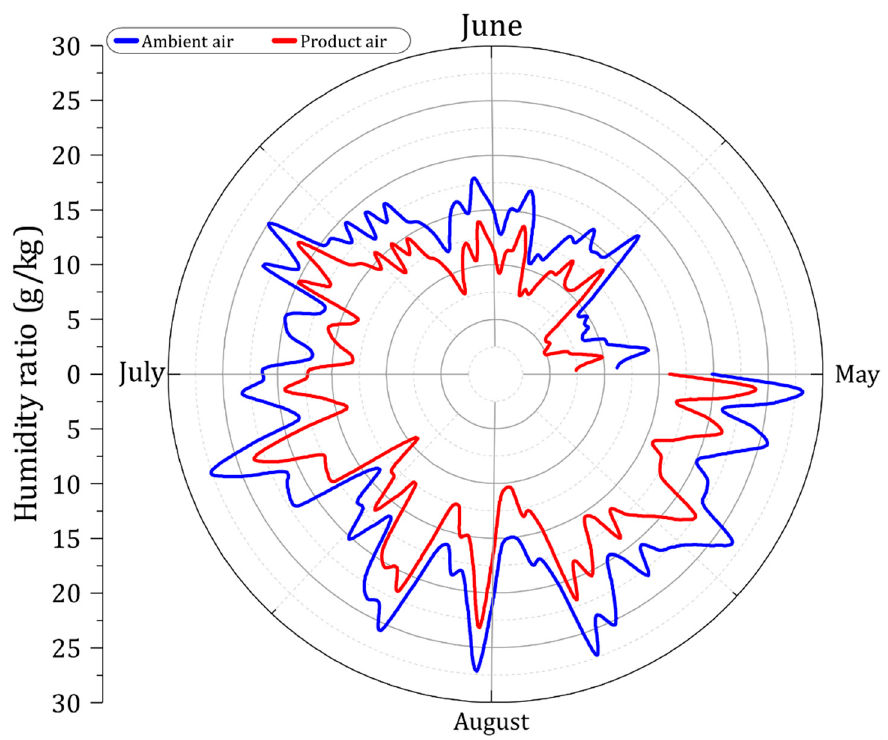
Figure 13. Performance profile of the proposed M-DAC system’s humidity ratio in summer months of Multan (Pakistan) for greenhouse air-conditioning application.